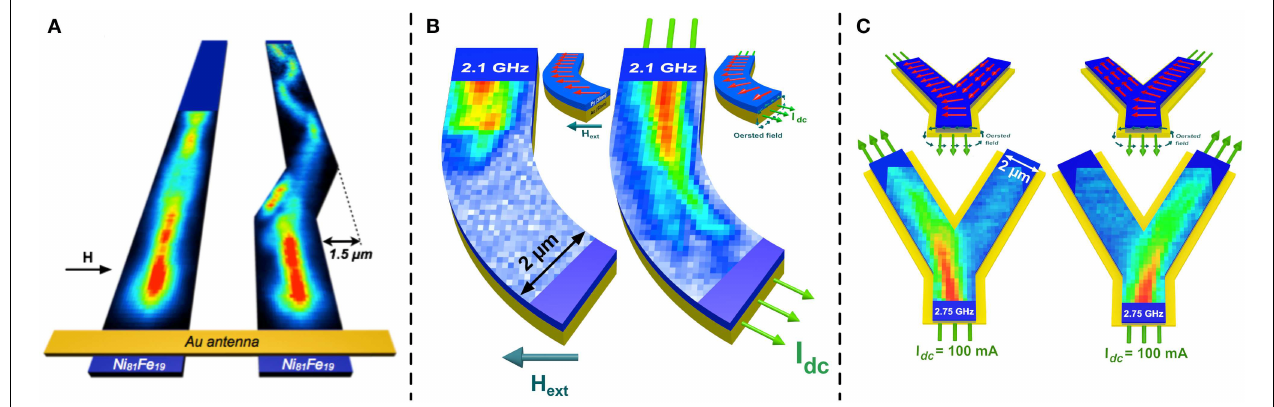
FIGURE 8 | (A) Distortion of a propagating spin-wave beam in a 2 . 5 - µ m wide permalloy stripe due to a skew section [91]. (B) Spin-wave propagation in global (left) and local magnetic fields (right) [46]. (C) Controlled switching of